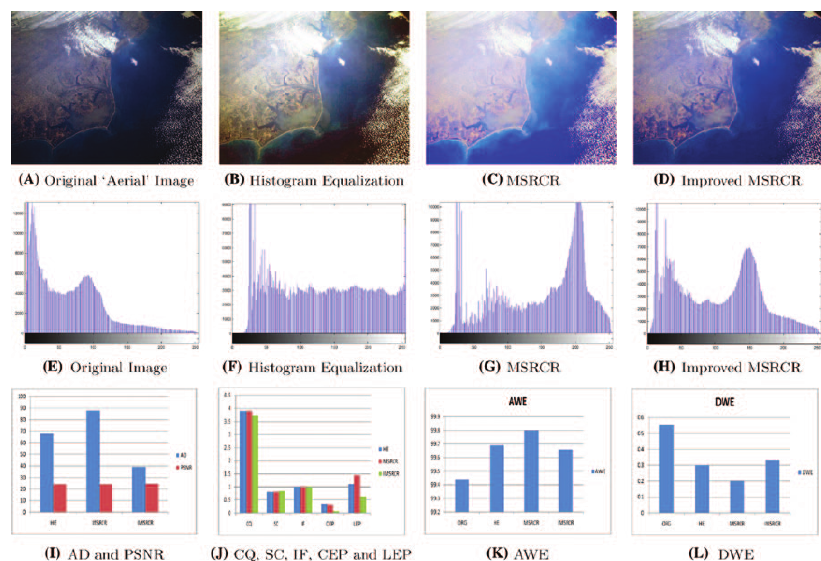
Figure 10. (Top) Image Enhancement Methods. (Middle) Histogram Plots: x -axis, Intensity Levels Ranging from 0 to 255; y -axis, Total Number of Pixels. (Bottom) Conventional Metrics and Proposed AWE and DWE Metrics. The “Aerial” Image has been Downloaded from